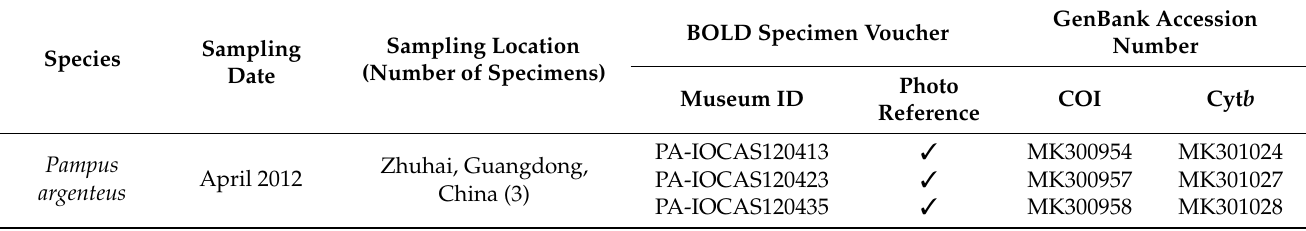
Table 1. Sampling data, BOLD sample IDs, and GenBank accession numbers of the Pampus species used in this study. The“ (cid:51) ” sign indicates that the specimen photo is available on BOLD.